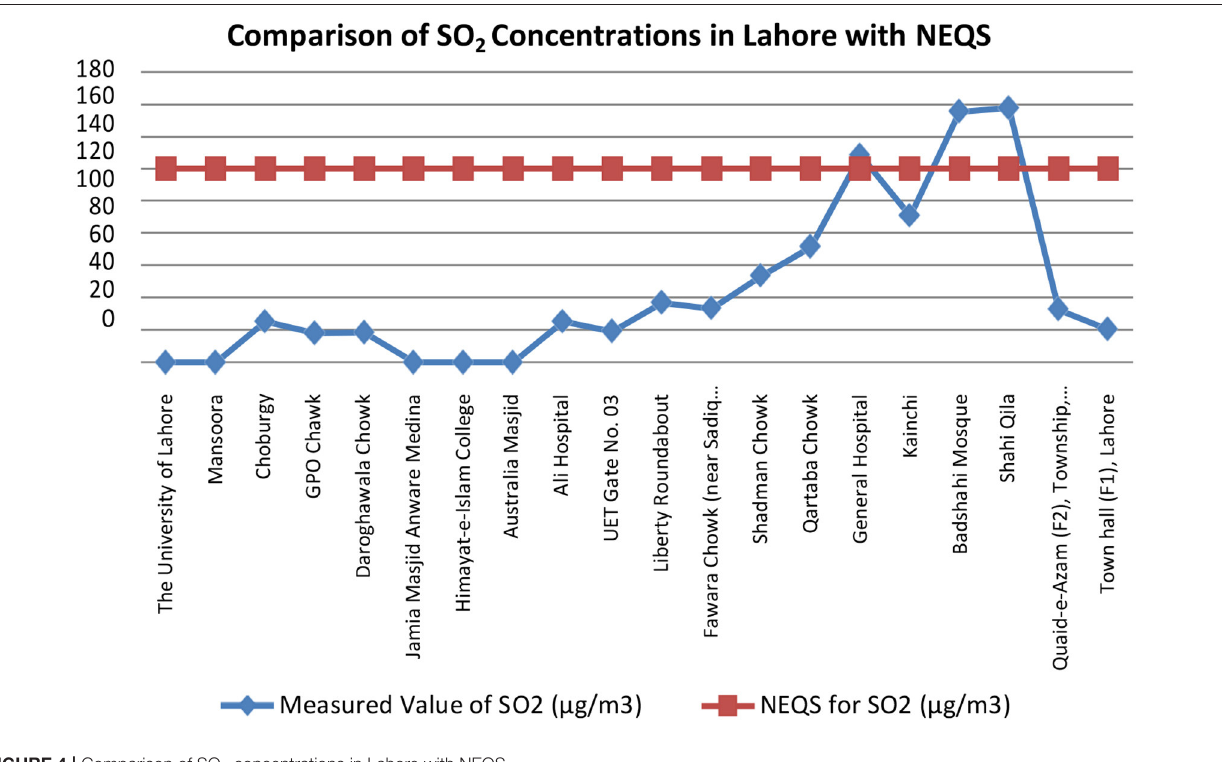
FIGURE 4 | Comparison of SO 2 concentrations in Lahore with NEQS.